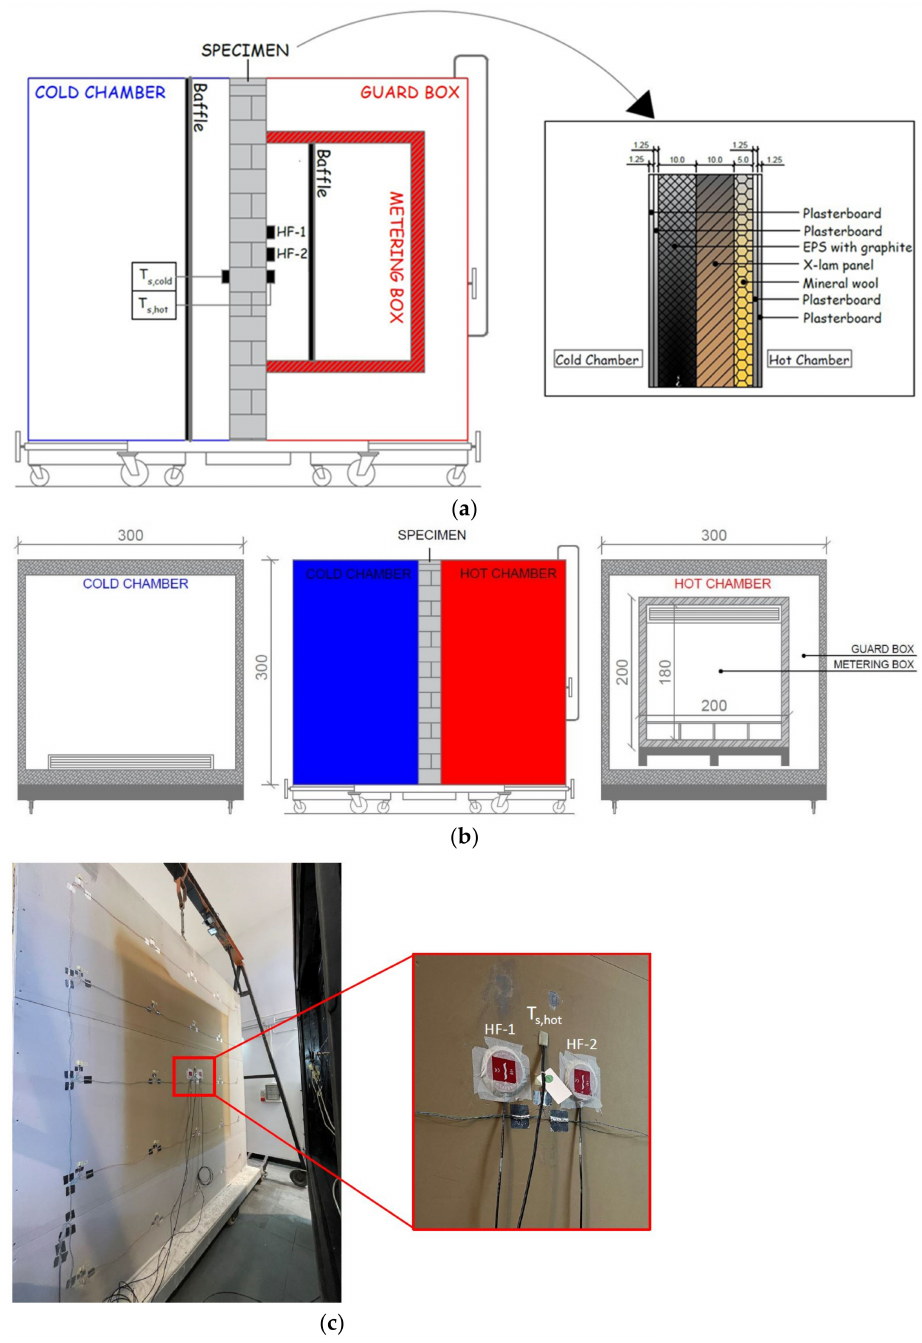
Figure 1. ( a ) Experimental setup and specimen wall (HF: heat flux meter; T s : surface temperature probe). ( b ) Dimensions of the GHB. ( c ) Picture of the experimental setup. (All the dimensions are in